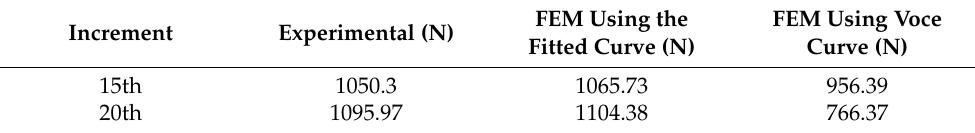
Table 3. Measured maximum forming force at 15th and 20th increments.